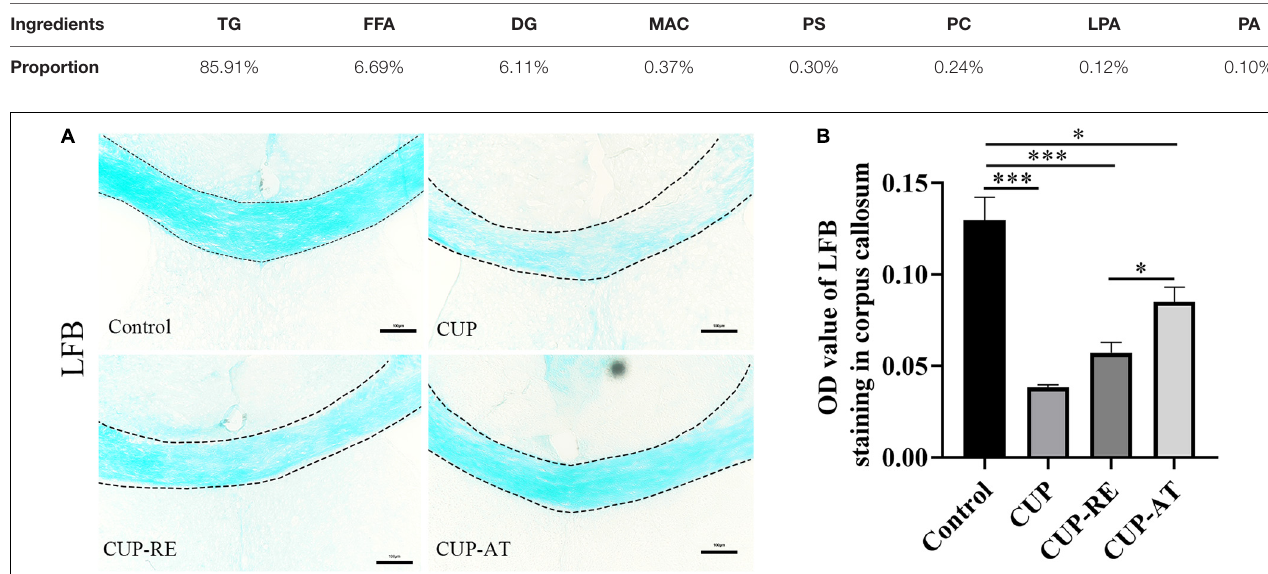
TABLE 1 | Main ingredients of Acer truncatum oil.